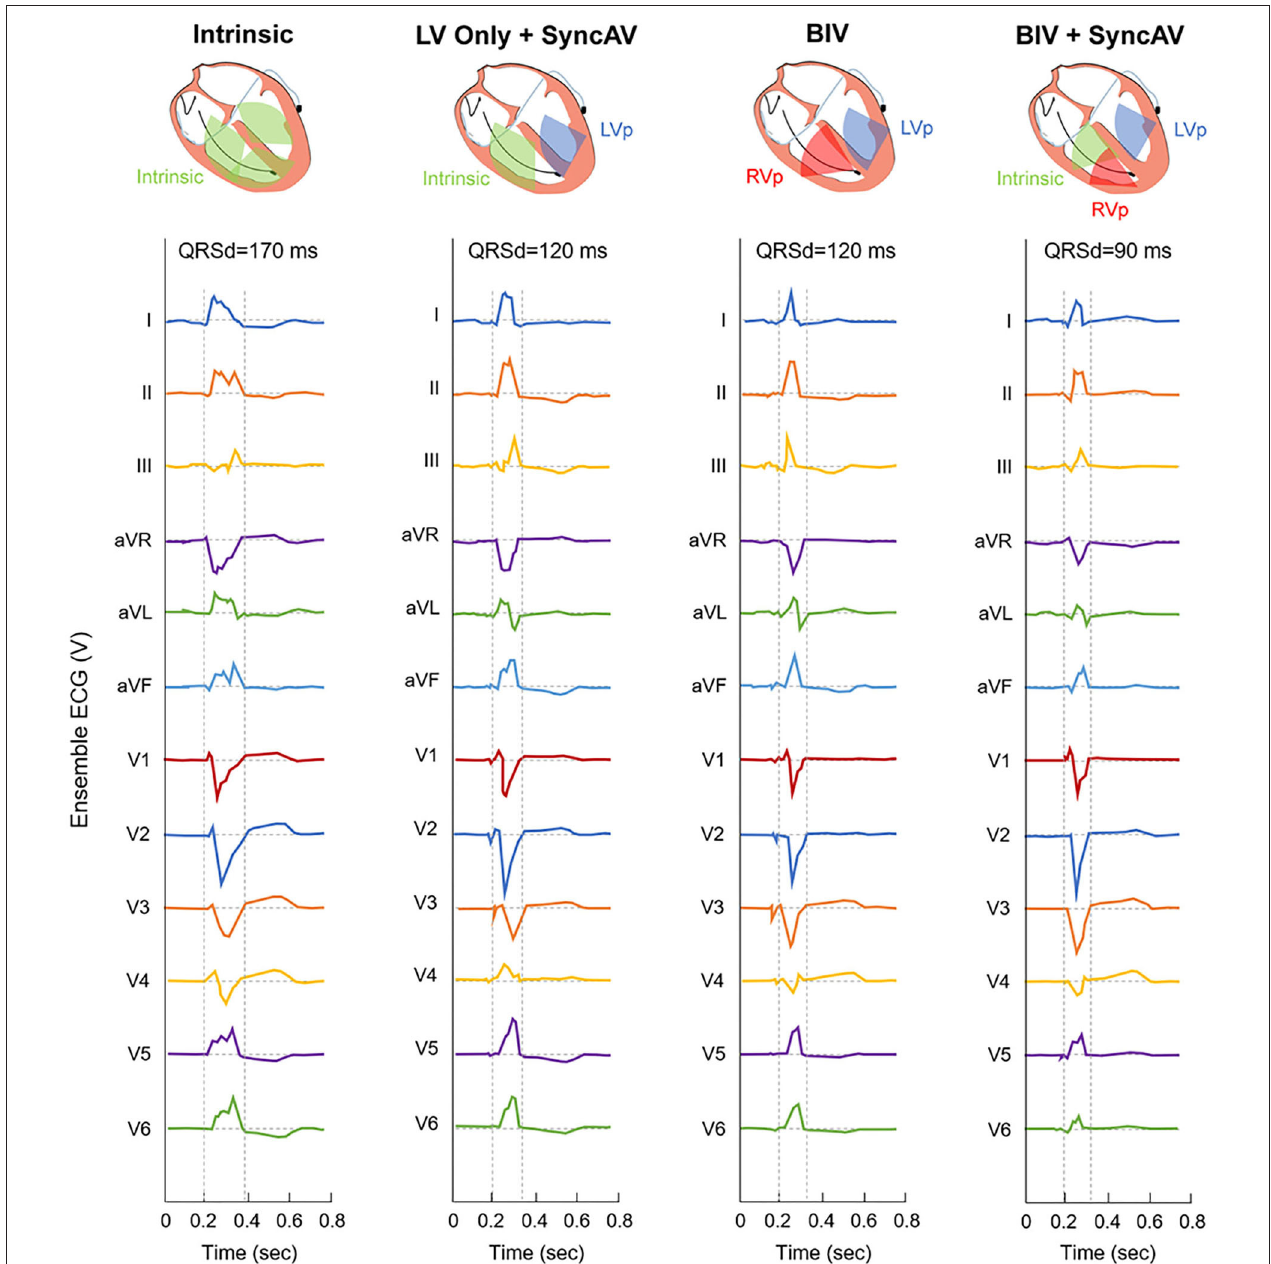
FIGURE 1 | Representative 12-lead ECG for QRS interval at intrinsic and three different pacing modes during post-implant optimization in a single